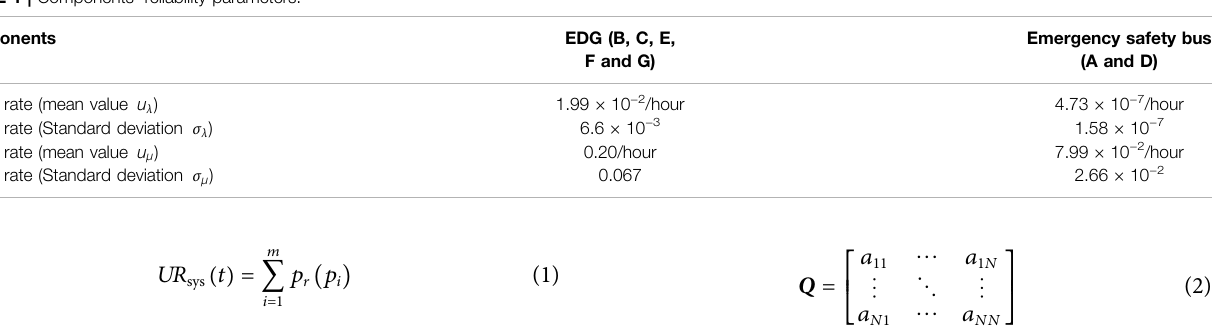
TABLE 1 | Components ’ reliability